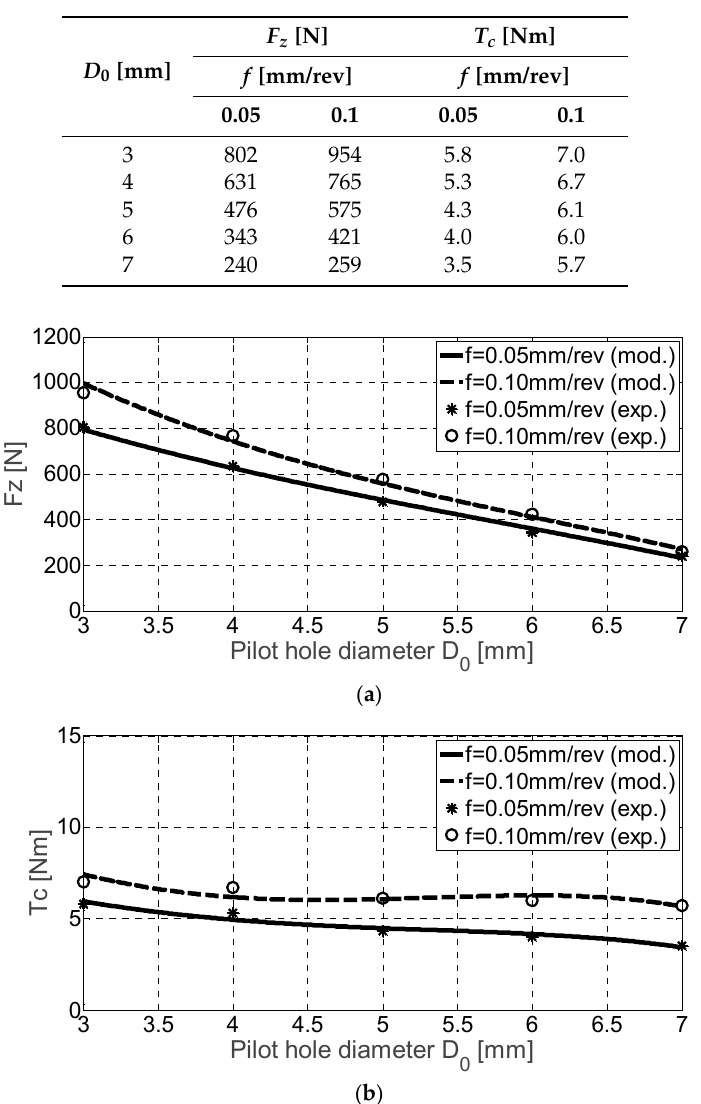
Figure 6. F z [N] ( a ) and T c [Nm] ( b ) for TNB alloy drilling experimental and mechanistic model values.